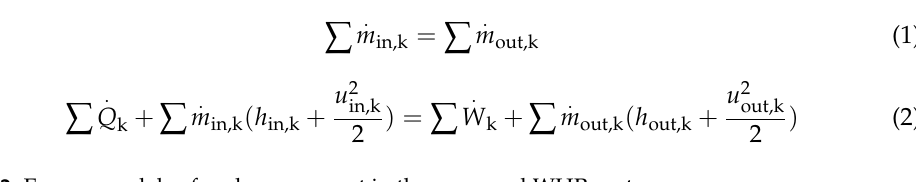
Table 2. Energy models of each component in the proposed WHR system. Cycle